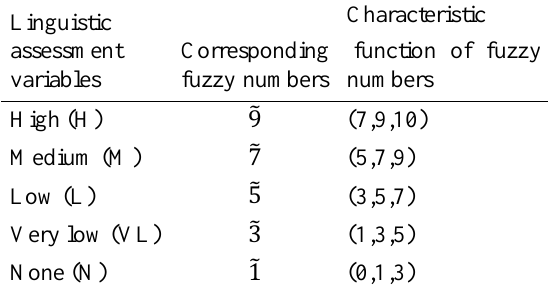
Table 2. Linguistic expressions and fuzzy numbers for impact of risks [43].